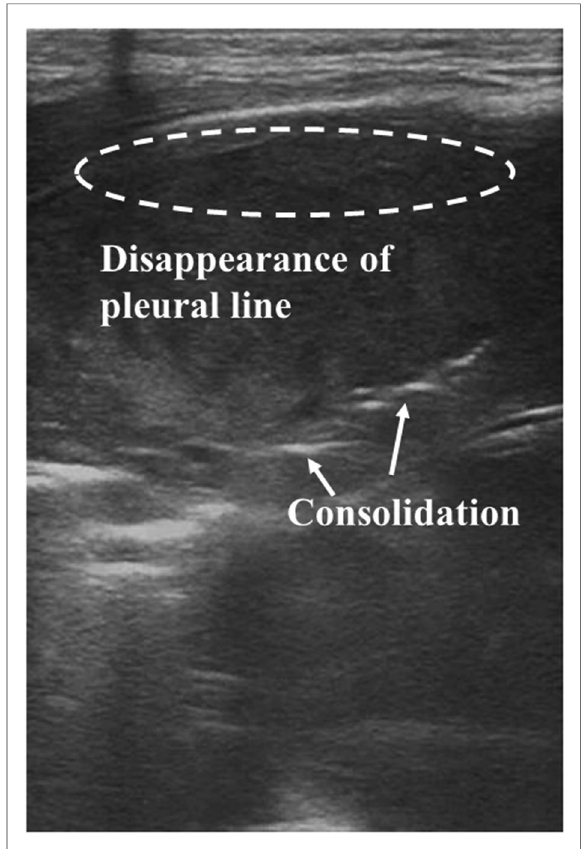
FIGURE 5 Pneumonia on lung ultrasonography. Ultrasound shows irregular areas of lung consolidation with air bronchograms, disappearance of the pleural line, and